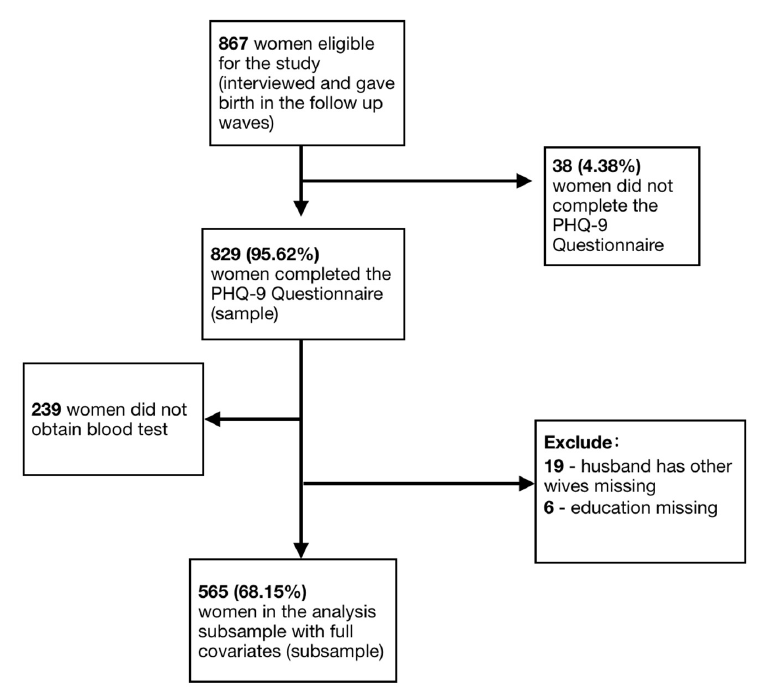
Figure 1. Flowchart of recruitment of final analytic sample and subsample. Table 1. Descriptive Statistics of total sample and analytic subsample.